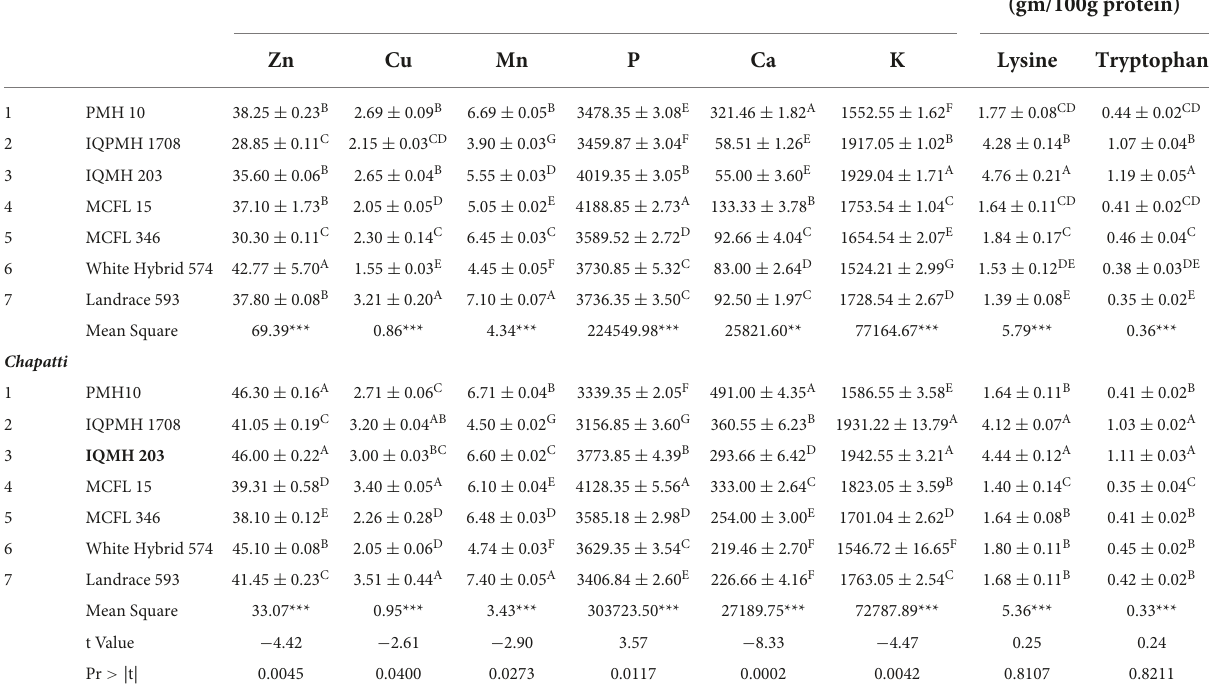
TABLE 4 Mineral and amino acid content of maize flours and chapatti prepared from different genotypes.